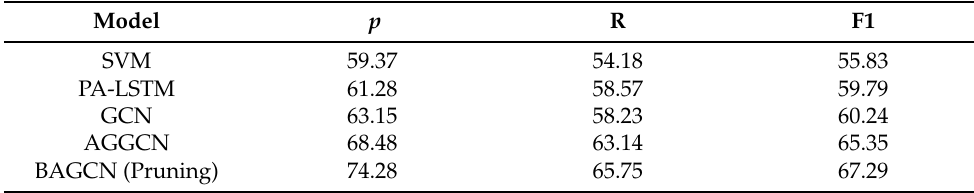
Table 4. Experimental results with baseline models (unit: